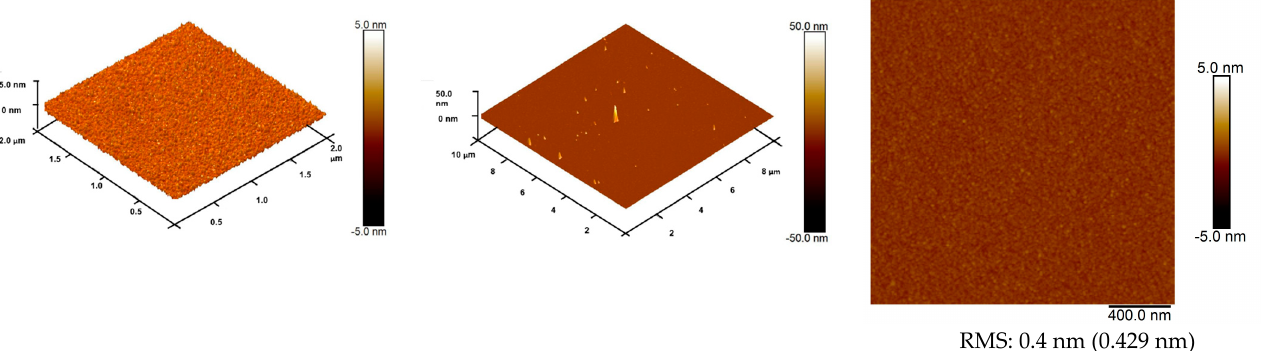
Figure 5. AFM images (2 × 2 μ m 2 and 10 × 10 μ m 2 ) and RMS roughness value of HfO 2 thin films (20 nm thick) grown with ALD from ozone (O 3 ) at 90°C on Si substrate.